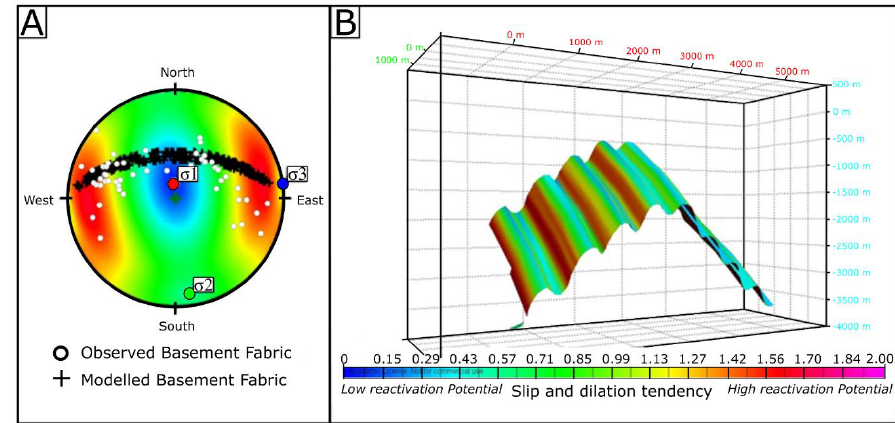
Figure 13. ( A ) Stereographic projection depicting observed ( white ) and modelled ( black ) basement metamorphic fabric measurements along with the slip and dilation tendency. ( B ) Graphical representation in MOVE TM of the surface that is used in the reactivation modelling and corresponds to the black points in ( A ). The surface in ( B ) is coloured with the slip and dilation tendency (reactivation potential) for the stress regime shown in ( A ).